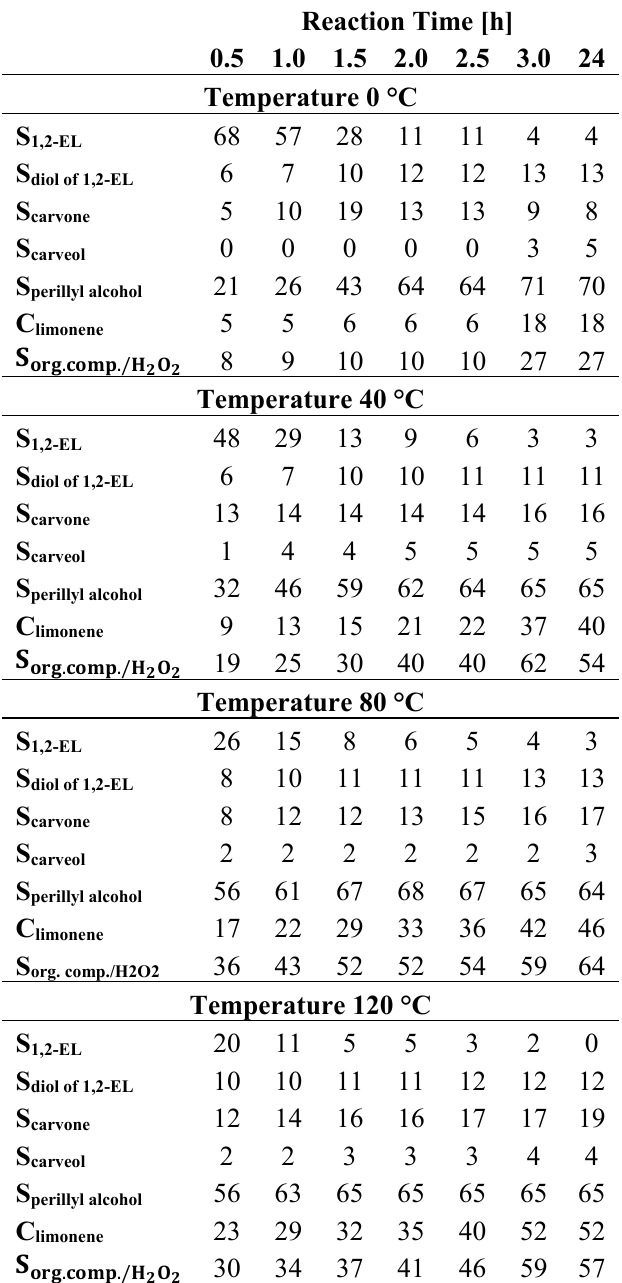
Table 2. Studies on the influence of the temperature and the reaction time on the course of limonene epoxidation over the Ti-SBA-15